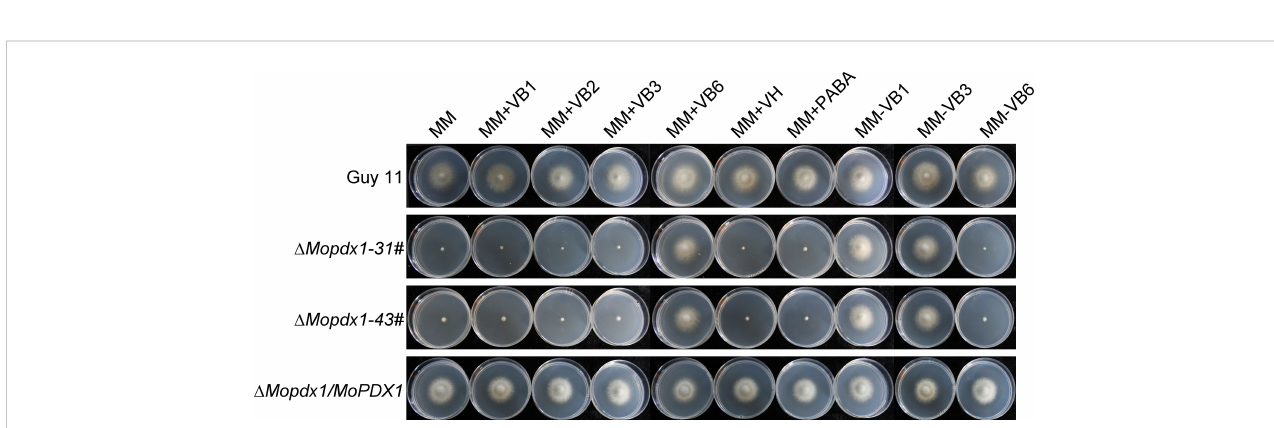
FIGURE 3 The addition of VB6 but not other kinds of vitamin B rescued the defect in vegetative growth of MoPDX1 deletion mutants. Hyphal blocks of indicated strains were cultured at 28°C for 7 days in the dark on MM media erther individually supplemented with VB1, VB2, VB3, VB6, VH, or PABA, or only lacking VB1, VB3, and VB6. Experiments were repeated three times with similar results.